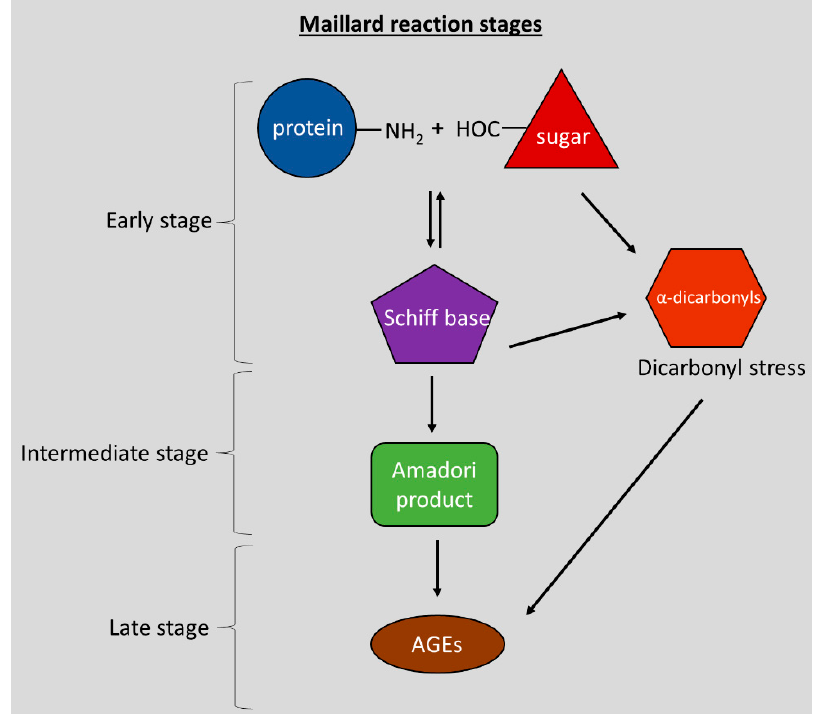
Figure 1. The three stages of Maillard reaction and the formation of AGEs and α -dicarbonyls.